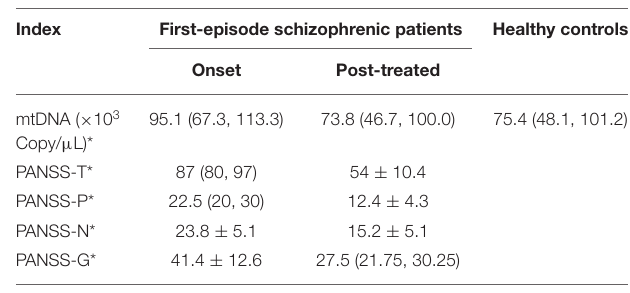
TABLE 1 | Demographic characteristics of first-episode patients with schizophrenia and healthy controls (HCs) enrolled in the study.